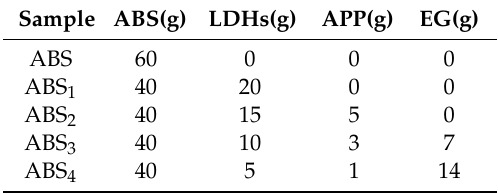
Table 1. Formulations of the flame retardant ABS with added O-CaMgAl-LDHs, APP, and